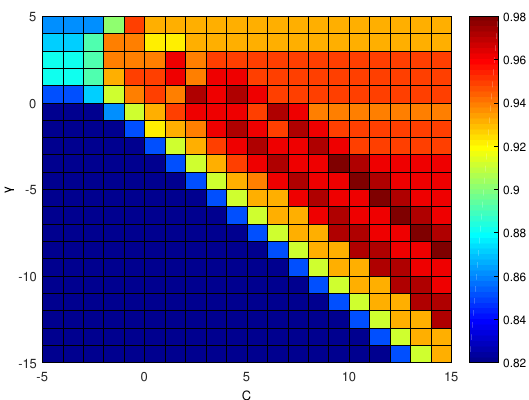
Figure 15. Identification accuracy under different ( C , γ ) parameter combinations.